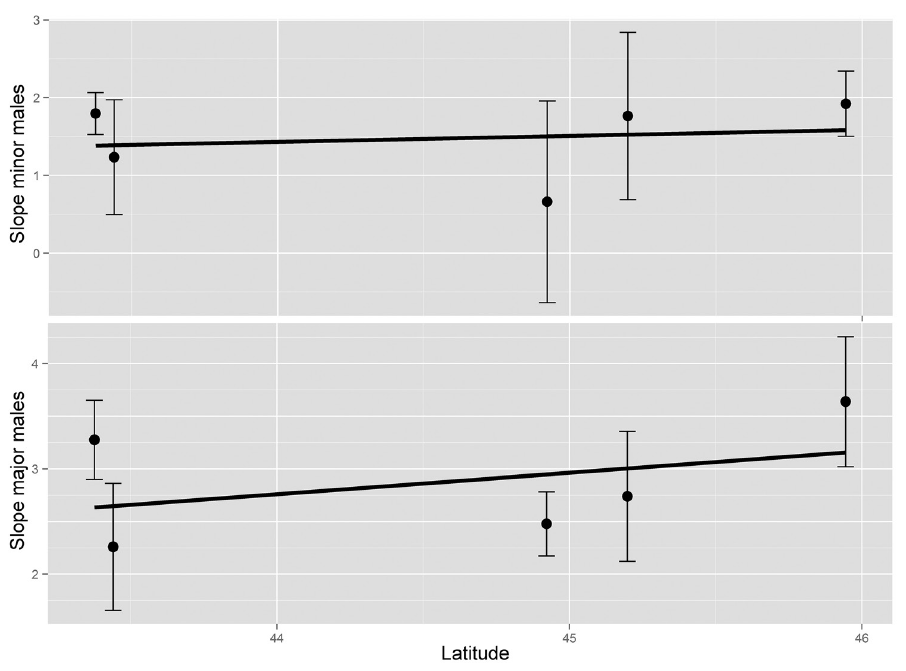
Figure 4. Allometric coefficient (± 95% confidence intervals) between weapon (LnML) and body size (LnEL) in relation to latitude for minor males and major males of Lucanus cervus